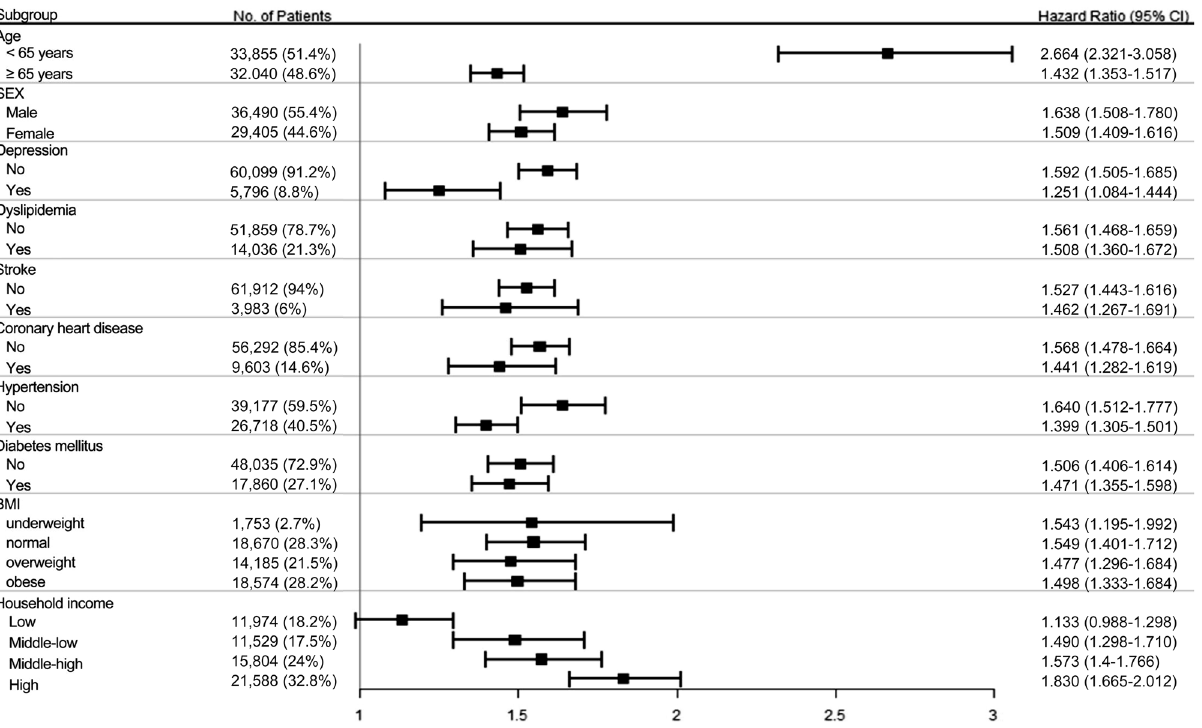
Figure 3. Forest plot for subgroup analyses based on age, sex, systemic comorbidities, BMI and household income level to examine the effect of VI on dementia. Forest plots were generated using the R forest plot package (https:// cran.r- proje ct. org/ web/ packa ges/ fores tplot/ fores tplot. pdf) 57